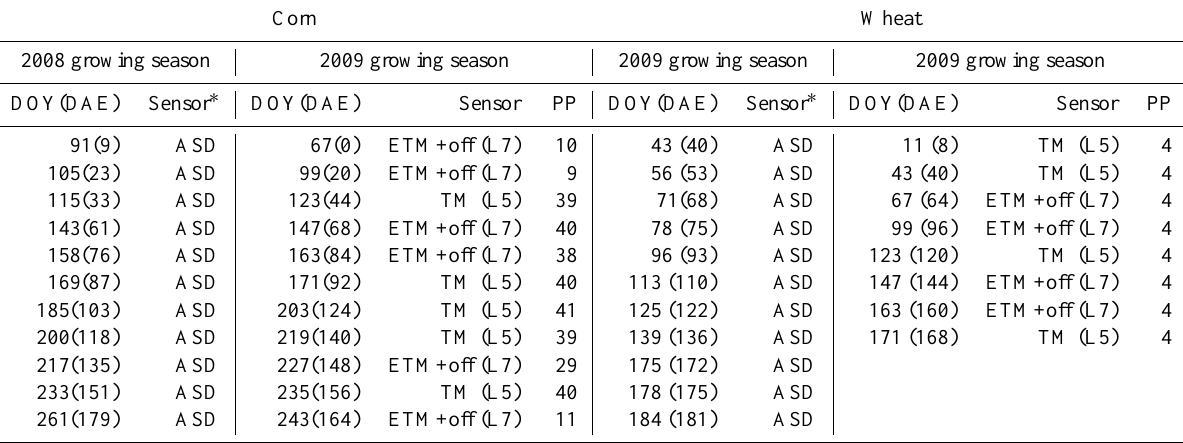
Table 3. Sensor, number of selected pure pixels (PP) for each field/date and dates (day of year and day after emergency) used for monitoring corn and wheat fields during 2008 and 2009 growing